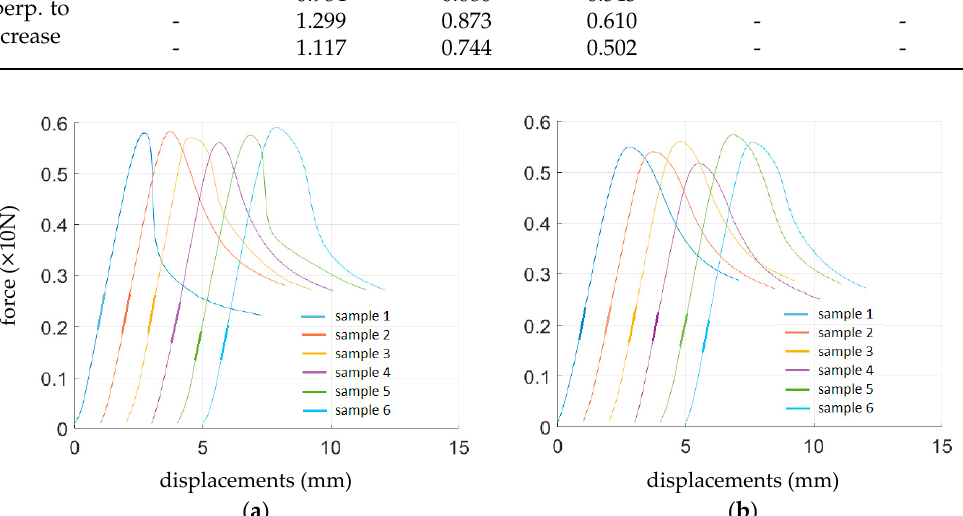
Figure 8. Bending stiffness test results from six samples of B370 corrugated board for each production technology: ( a ) analog and ( b ) digital crease lines.